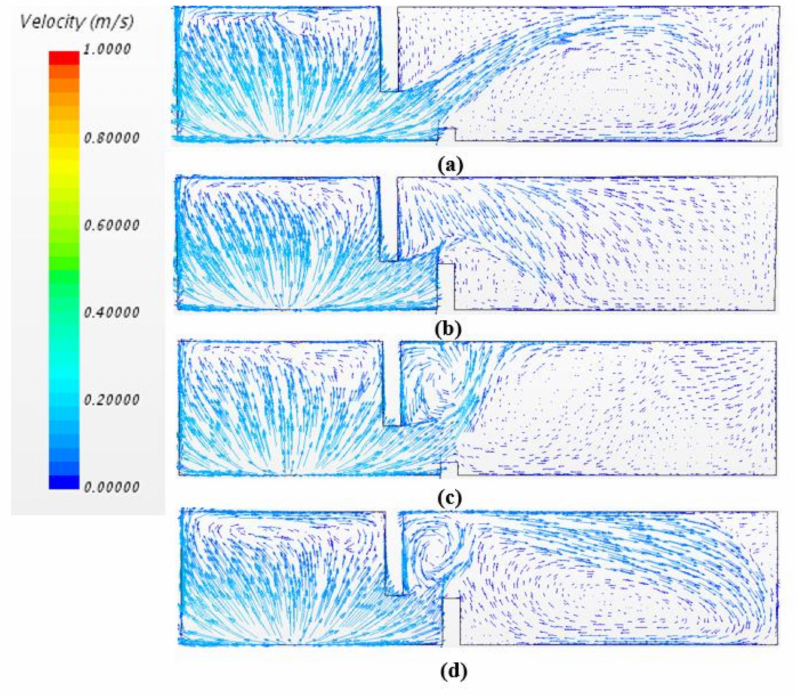
Figure 6. Velocity vectors at sidewall longitudinal plane: ( a ) Case 1-W + LD, ( b ) Case 2-W + HD, ( c ) Case 3-W + LD + G, ( d ) Case 4-W + HD +